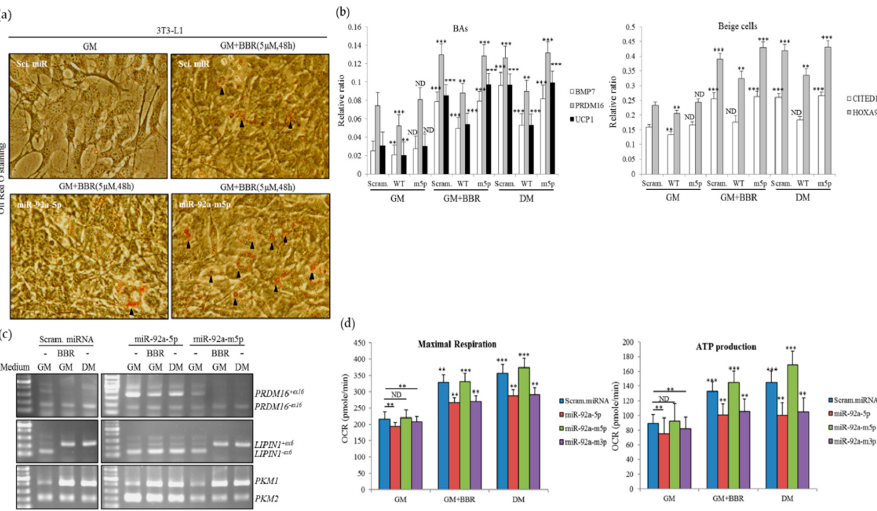
Figure 6. Overexpression of miR-92a interferes with BBR-mediated beige adipogenesis. ( a ) 3T3-L1 cells